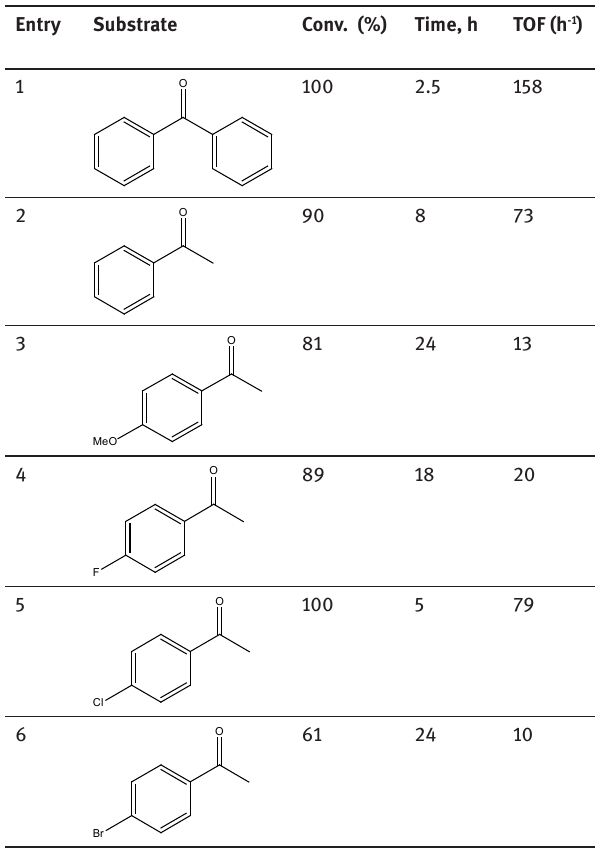
Table 1 : Transfer hydrogenation of different ketones using catalyst 1 . Entry